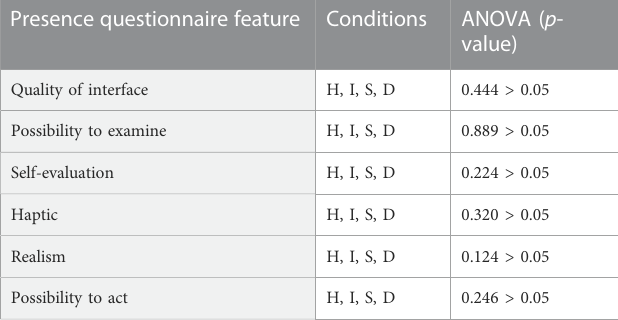
TABLE 4 Results of ANOVA test for presence questionnaire features between different conditions (H: Haptic, I: isomorphic, S: speed-control, D: direct-weight). Presence questionnaire